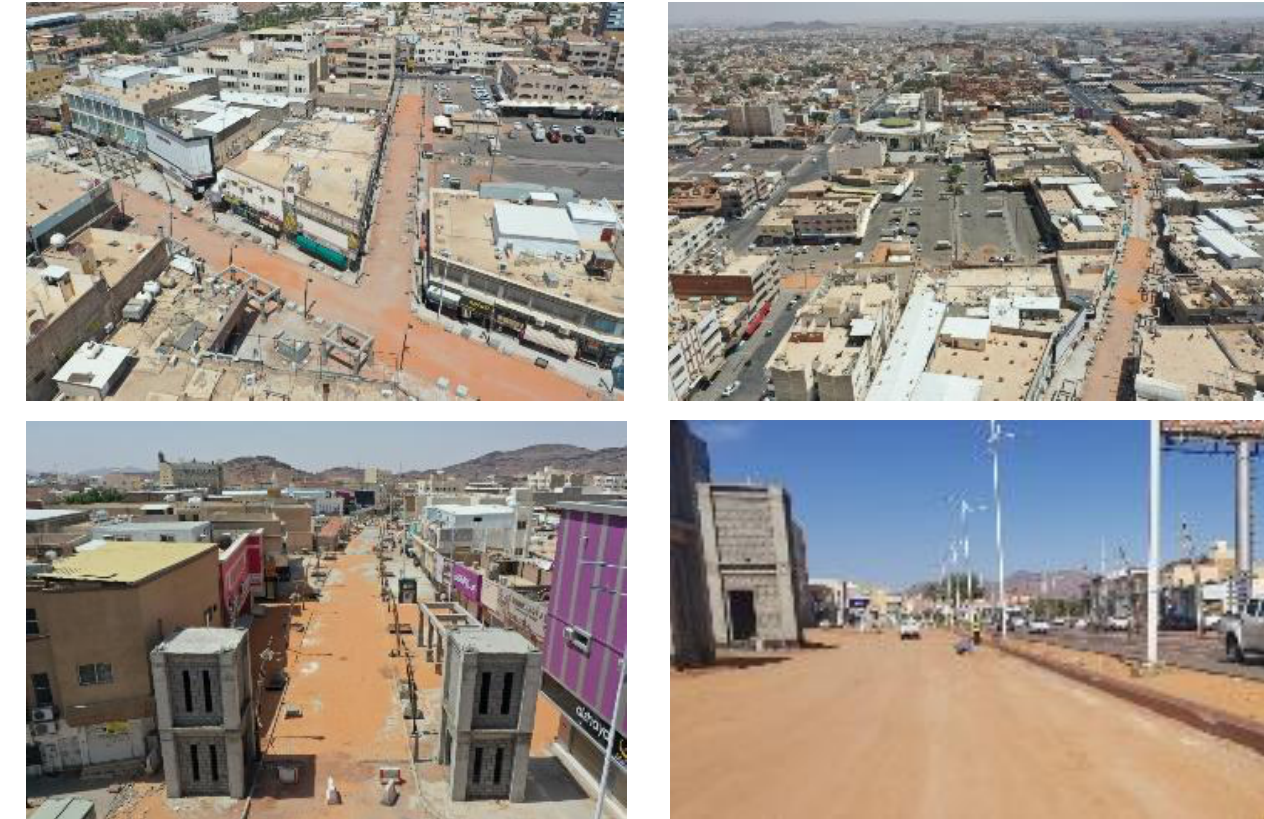
Figure 7. Barzan marketplace main street under development. Source: Authors.